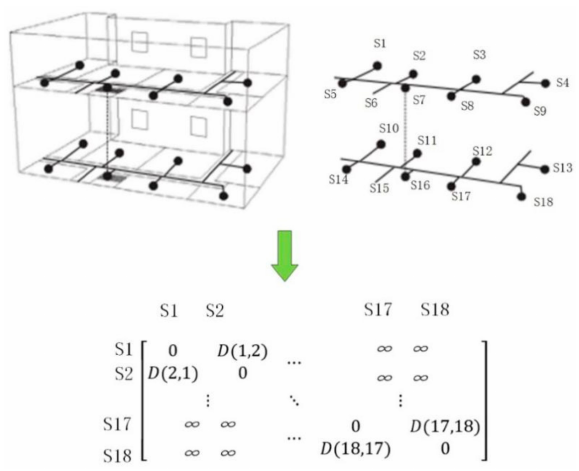
Figure 4. Geometric network